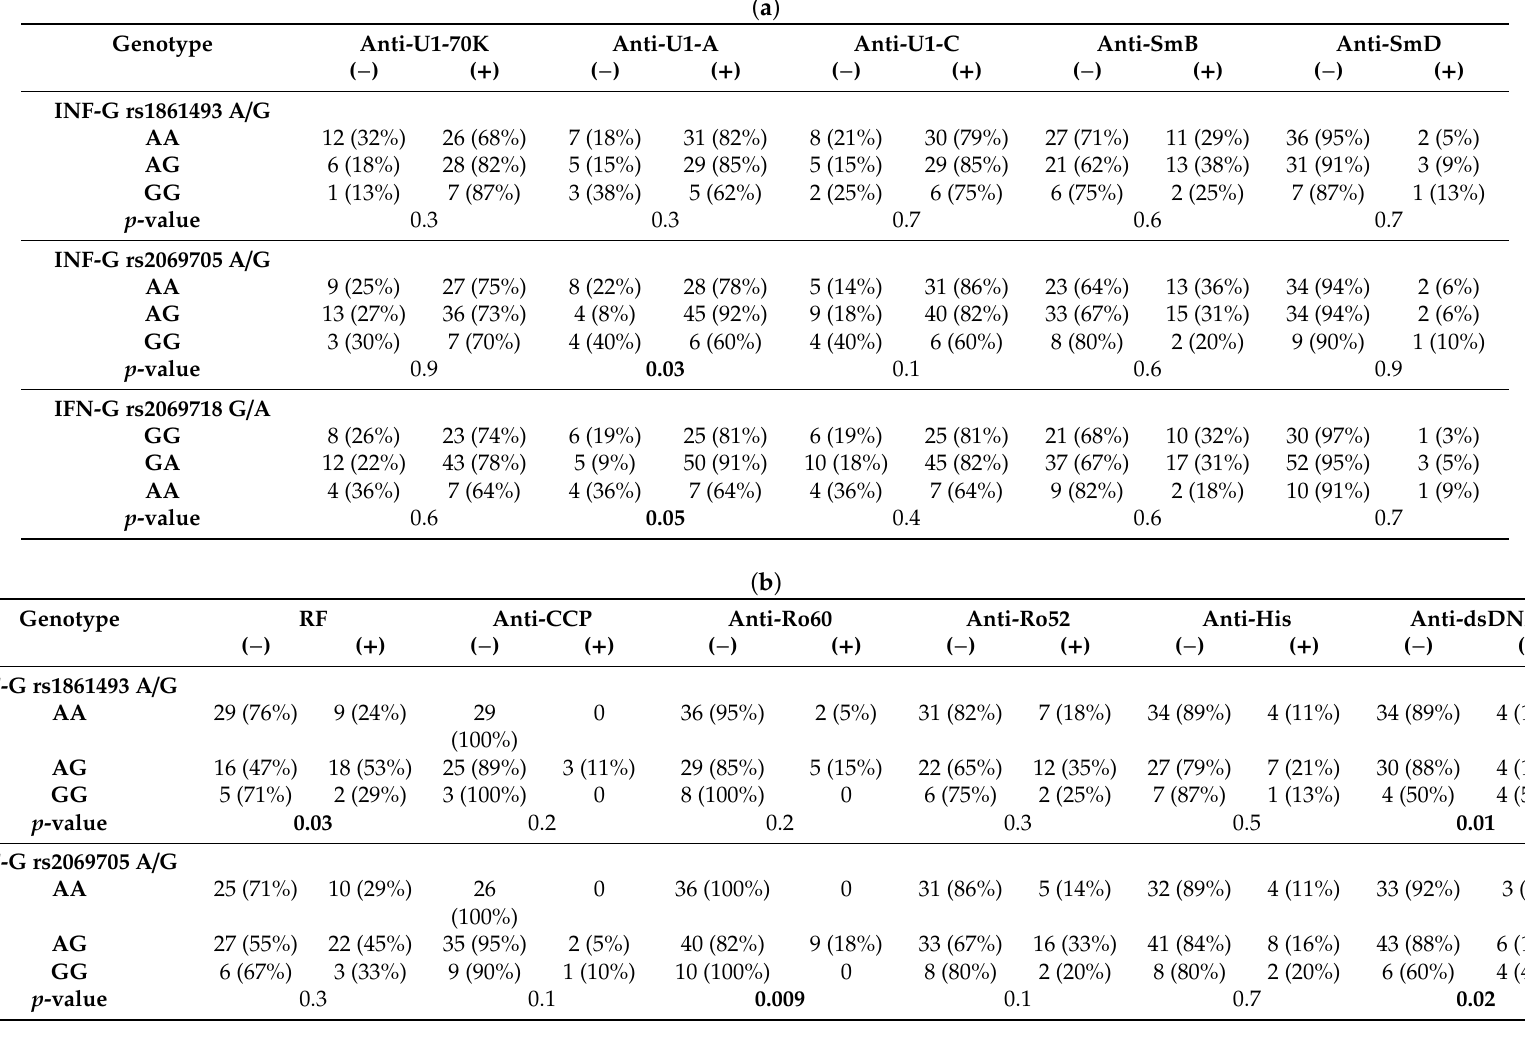
Table 8. IFNs genotypes in relation to antibody profiles in MCTD